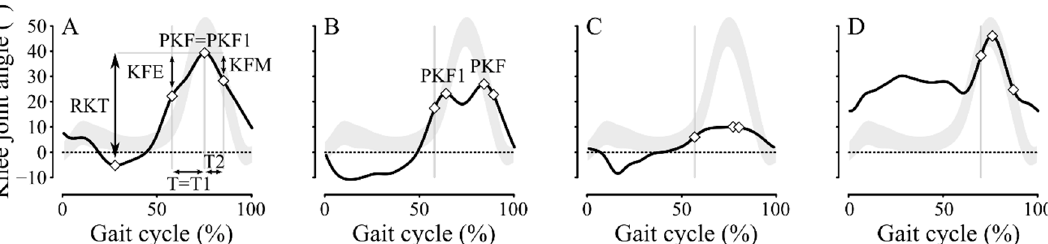
Figure 1. Sagittal knee joint angles for a complete gait cycle in 4 patients (black lines) and mean ± standard deviation (SD) interval in healthy group (grey areas). ( A ) Patient with UKG from k1 cluster. ( B ) Patient with BKG from k2 cluster. ( C ) Patient with FLG from k3 cluster. ( D ) Patient with non-SKG pattern from k4 cluster. The 5 kinematic parameters used to feed the machine learning algorithm were: (1) the first peak knee flexion angle (PKF1), (2) the angle difference (KFE) between PKF1 and the knee flexion angle at homolateral toe-off (grey vertical bars), (3) the duration from homolateral toe-off to PKF1 (T1), (4) the angle difference (KFM) between PKF1 and the knee flexion angle at the end of the mid-swing when the homolateral tibia is vertical, and (5) the duration from PKF1 to the end of the mid-swing (T2). Total range of knee flexion (RKT) is also shown.